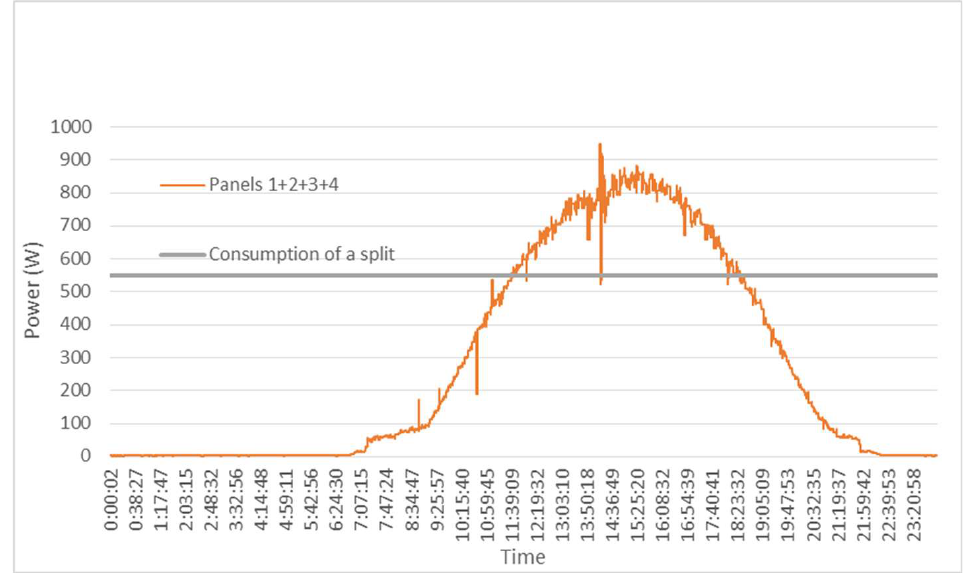
Figure 24. Example of daily electricity production (10 July 2015) in the four-panel photovoltaic facility.